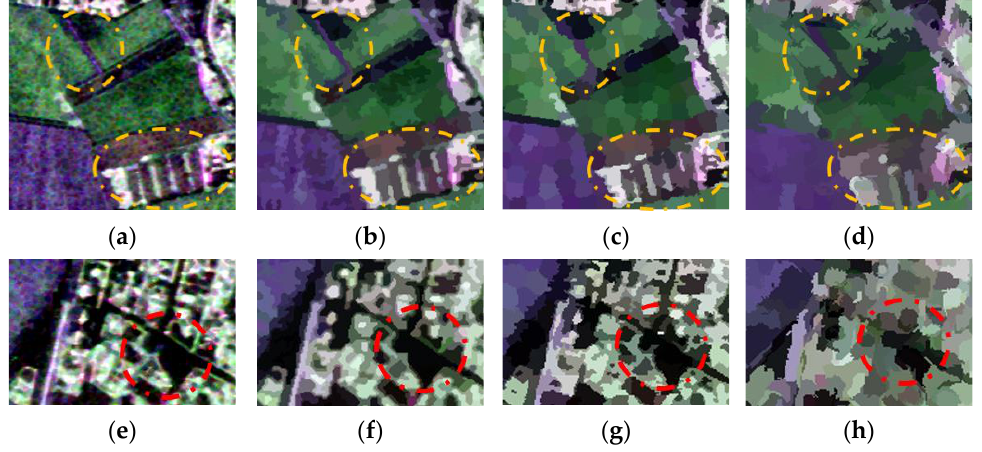
Figure 9. Detailed comparison of segmentation results of different algorithms enlarged from the yellow rectangles in Figure 3b; ( a ) original PauliRGB image; ( b , f ) are the final superpixel segmentation results of the proposed method; ( c , g ) are the final superpixel segmentation results of the Pol-ASLIC; ( d , h ) segmentation results derived from the Pol-ERM.